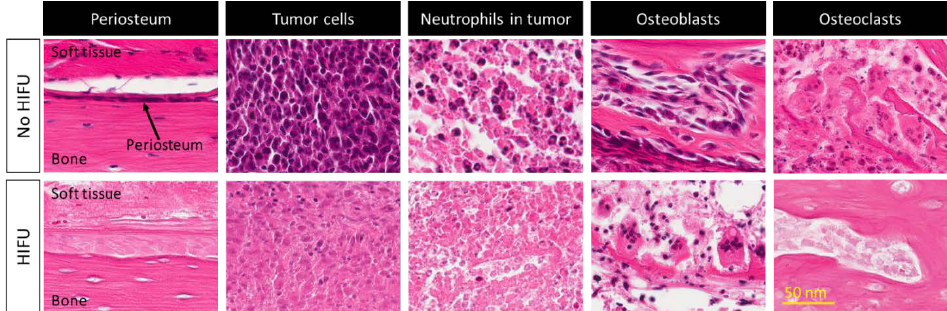
Figure 3. Histological images (hematoxylin and eosin) of viable and necrotic periosteum, tumor cells, neutrophils in tumor microenvironment, osteoblasts, and osteoclasts before and after MR-HIFU treatment, respectively, in a preclinical osteoblastic rat model. Figures adapted and reprinted from Bone, Volume 81, Yeo SY, Elevelt A, Donato K, van Rietbergen B, ter Hoeve ND, van Diest PJ, and Grüll H, Bone Metastasis Treatment Using Magnetic Resonance-guided High Intensity Focused Ultrasound, 513–523, 2015, with permission from Elsevier (Amsterdam, The Netherlands) [29].